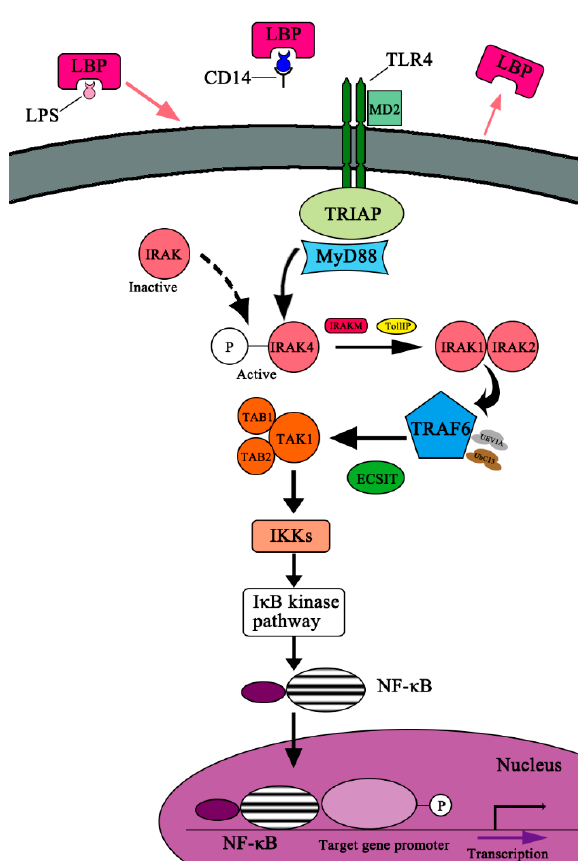
Figure 2. Diagram of LPS-induced TLR4 signaling. LPS, the breakdown bacterial component, binds to LBP, and then is released from the LPS-LBP complex, and is presented to CD14 and TLR4 on APCs, leading to the activation of TLR4. With the assistance of MD-2, an important component of activated TLR4, termed Toll/IL-1 receptor (TIR) homologous domain, binds to the C-terminus of cytoplasmic adaptor proteins MyD88, while the death domain (DD) at the N-terminus of MyD88 interacts with intercellular enzyme IL-1 receptor-associated kinase (IRAK), eventually resulting in the phosphorylation of IRAK and the activation of TNF- α receptor-associated factor 6 (TRAF-6). The phosphorylated IRAK binds to the activated TRAF, and the complex activates TGF- β -activated Kinase-1(TAK1), triggering the activation of inhibitor of κ polypeptide gene enhancer in B-cells (I κ B) kinase, eventually activating the NF- κ B signaling pathway. The NF- κ B signaling pathway upregulates the expression levels of the target gene. The activated NF- κ B signaling initiates the expression of target genes, leading to the damage of target organs. TLR4 = Toll-like Receptor-4; LBP = lipopolysaccharide-binding Protein; TIR = Toll-Interleukin-1-Receptor; TIRAP = Toll-Interleukin-1-Receptor Domain-containing Adapter Protein; MyD88 = Myeloid Differentiation Primary Response Protein-88; IRAK = Interleukin-1 Receptor-associated Kinase; IRAKM = Interleukin-1 Receptor-associated Kinase-M; TollIP = Toll-Interacting Protein; TRAF6 = Tumor Necrosis Factor Receptor-associated Factor-6; UbC13 = Ubiquitin-conjugating Enzyme-13; UEV1A = Ubiquitin-conjugating Enzyme E2-Variant-1; ECSIT = Evolutionarily Conserved Signaling Intermediate in Toll Pathways; TAK1 = TGF- β -activated Kinase-1; TAB1 = TAK1-binding Protein-1; TAB2 = TAK1-binding Protein-2; IKKs = Inhibitor of κ Light Polypeptide Gene Enhancer in B-Cells Kinase.